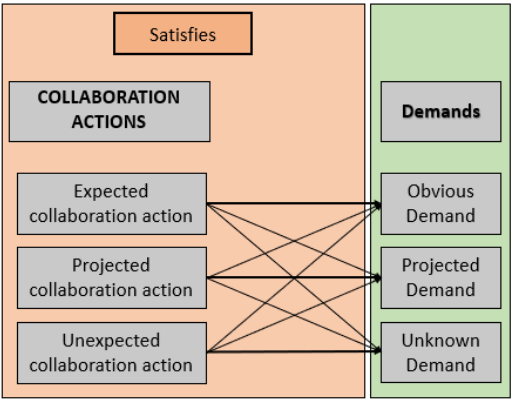
Figure 5. Actions and needs